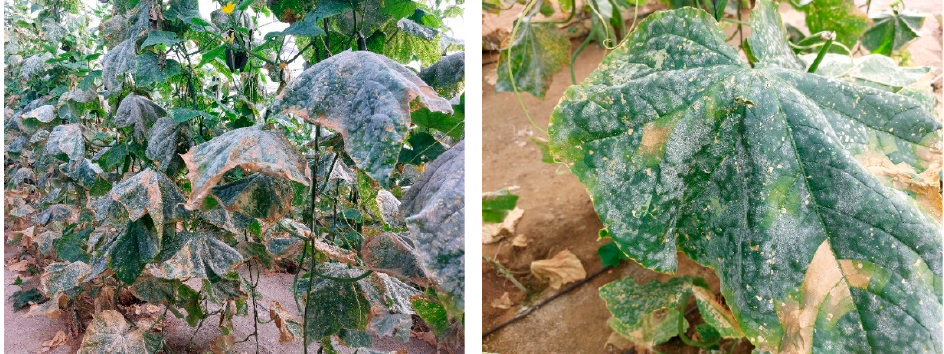
Figure 2. Cucumber leaves affected for different study diseases.